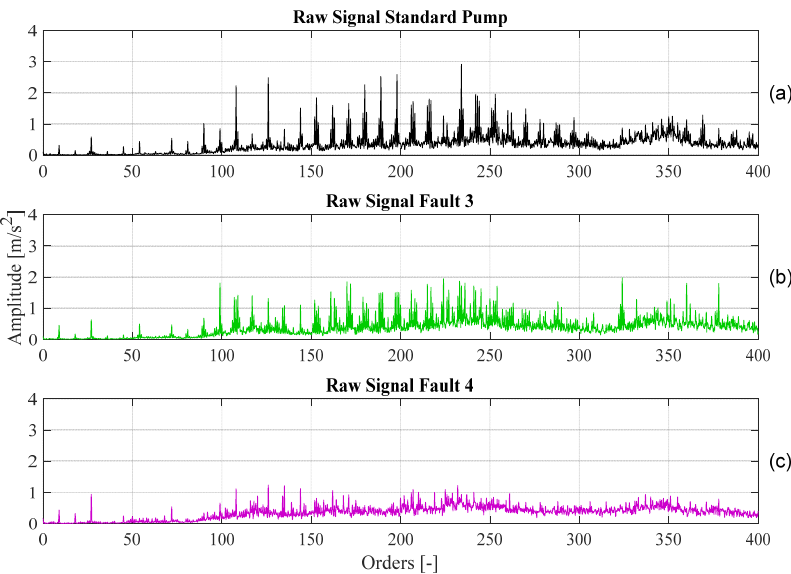
Figure 7. FFT of the raw signal for ( a ) the standard pump, ( b ) fault 3, and ( c ) fault 4 pump for the signal acquired with sensor 1 (1500 r/min, 150 bar).